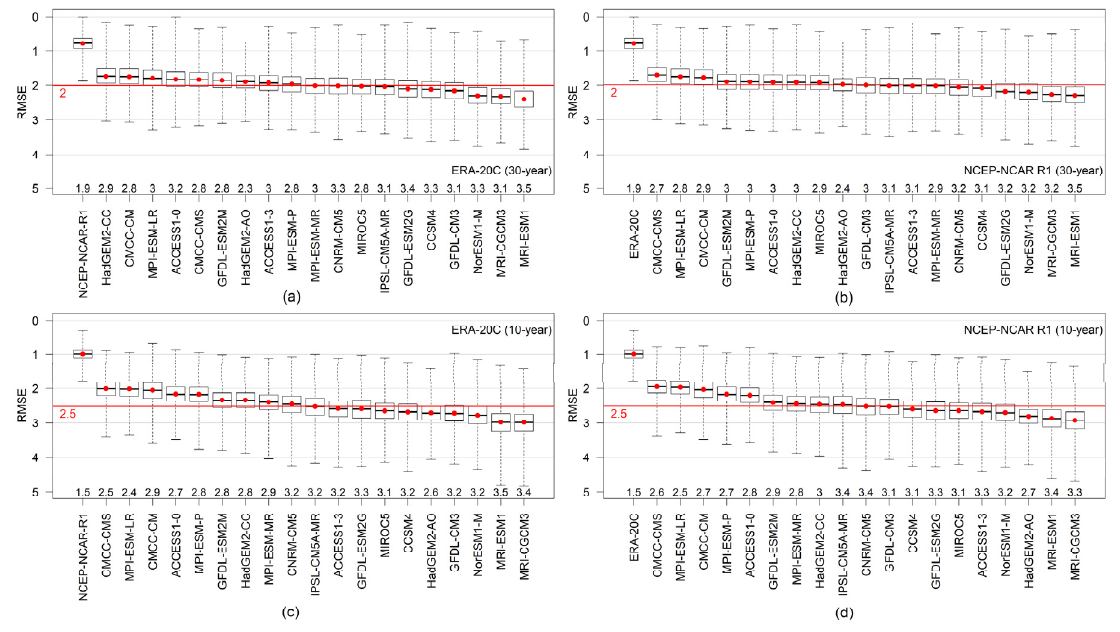
Figure 4. Distribution of root-mean-square error (RMSE) values with respect to ( a , c ) the ERA-20C and ( b , d ) the NCEP-NCAR R1 obtained from Monte Carlo simulations based on the stability patterns of ( a , b ) 30-year-long and ( c , d ) 10-year-long periods. GCMs are ranked according to their RMSE median. The ranges of the RMSE values are displayed above the x axis. The RMSE values that were computed by taking into account all grid cells in the Northern Hemisphere (NH) are plotted with red circles while the RMSE median of the GCMs is represented with a red straight line with the corresponding value.